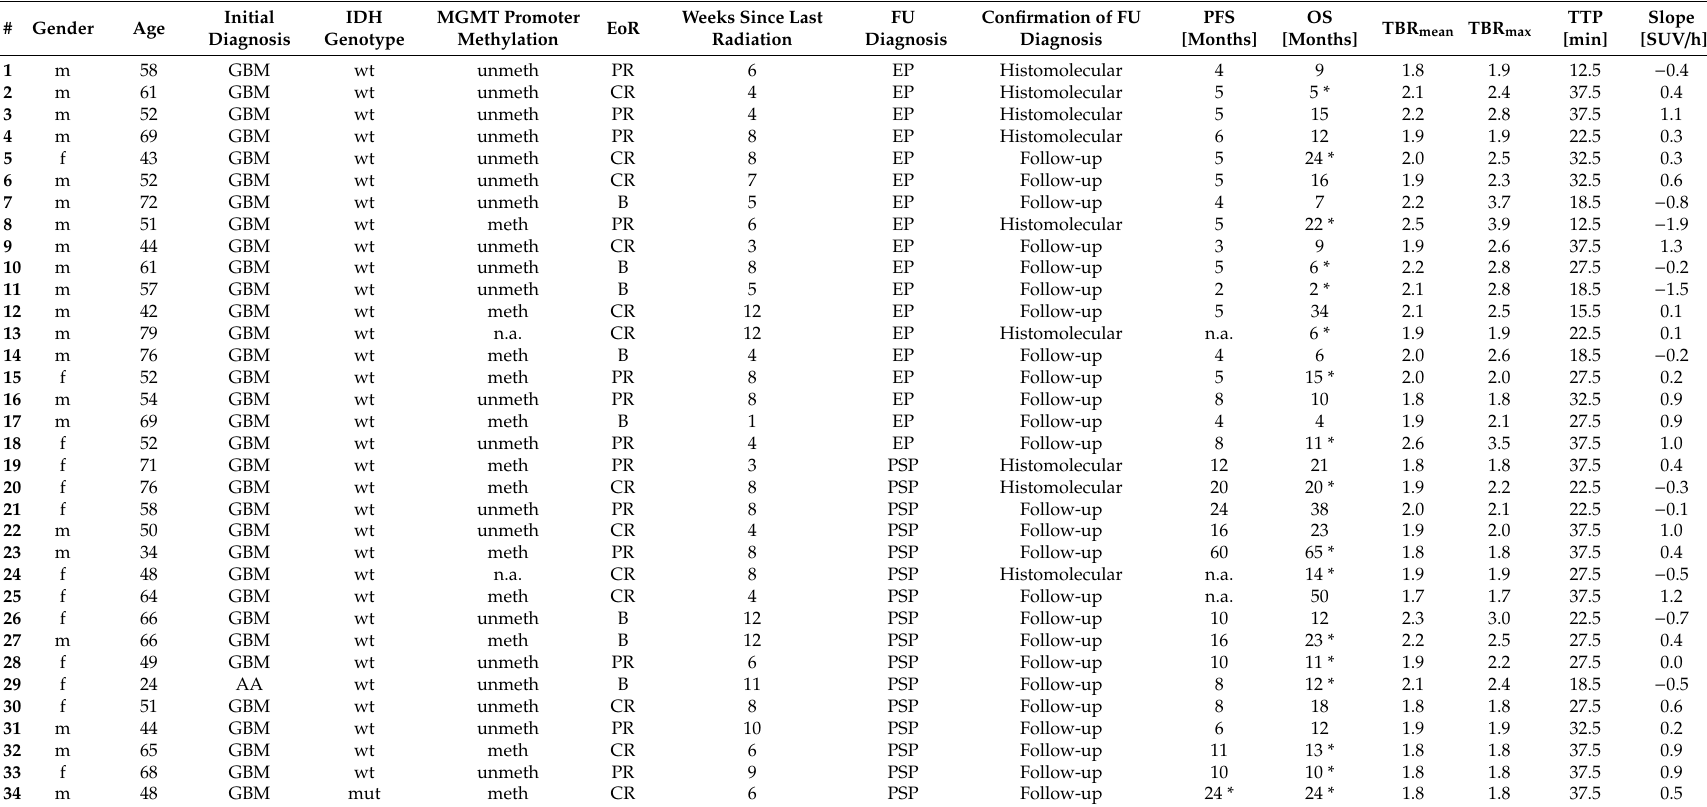
Table 1. Overview of the patient